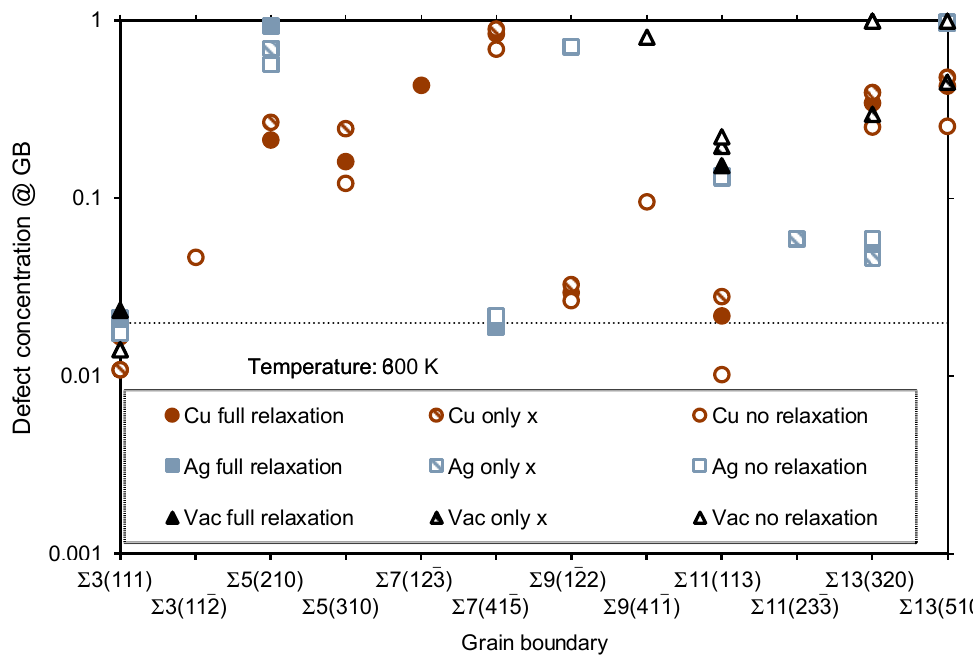
Figure 5. The defect concentration of point defects at the ∑ GBs listed in Table 1 and depicted in Figure 1 at T = 600 K. It is shown for the defects Cu Pd (red circles), Ag Pd (blue squares), and V Pd (black triangles), using three VRTs: full volume relaxation (filled symbols), relaxation along the x direction only (half-filled symbols), and no volume relaxation (open symbols). The overall (bulk) defect concentration (chosen to be 0.02) is shown by the black, dotted line.